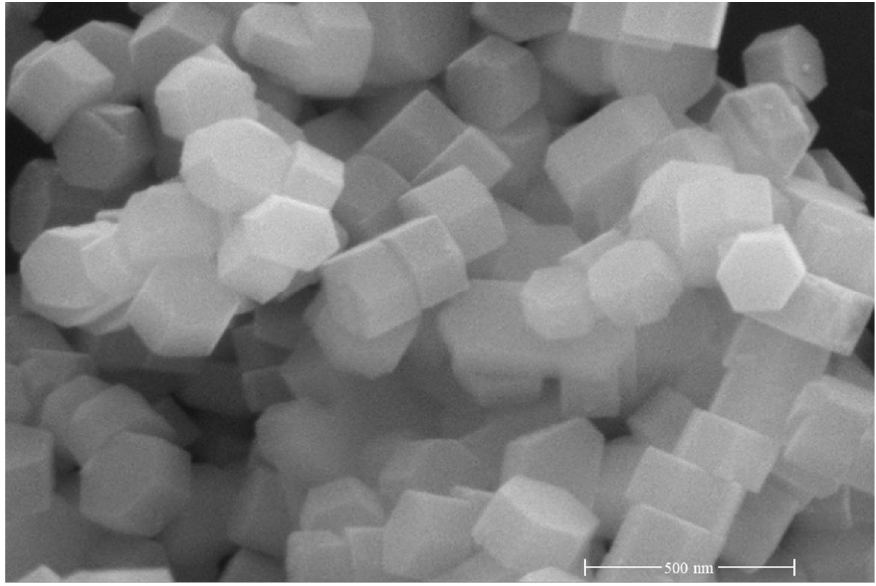
Figure 9. Microscopic morphology of poly